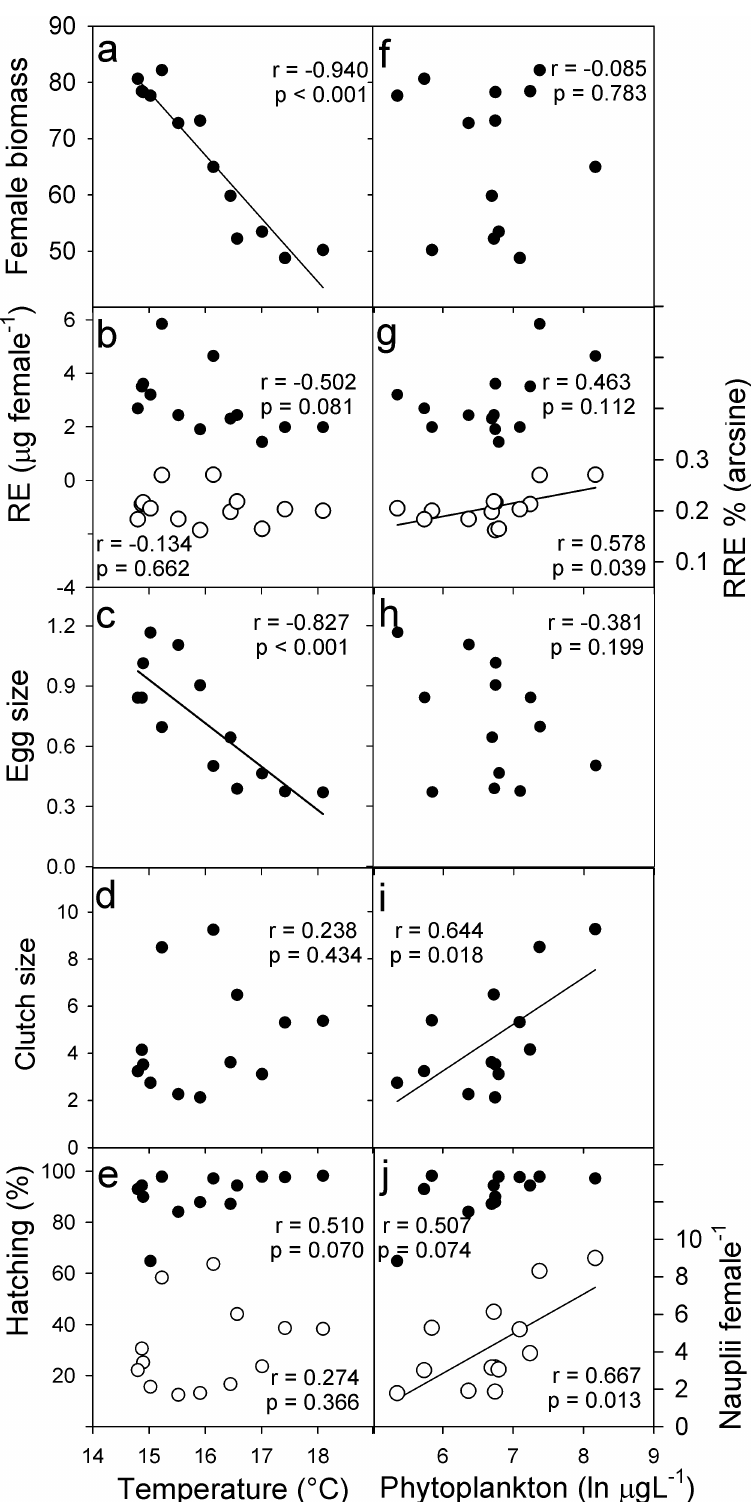
Fig 5. Dispersion plots of the average values of life-history traits of female L . garciai vs. temperature and food availability in Lake Alchichica. Probability and r coefficient values correspond to Pearson’s correlation tests; a significant correlation between the variability of a trait vs. temperature or phytoplankton is considered evidence of phenotypic plasticity to that factor.